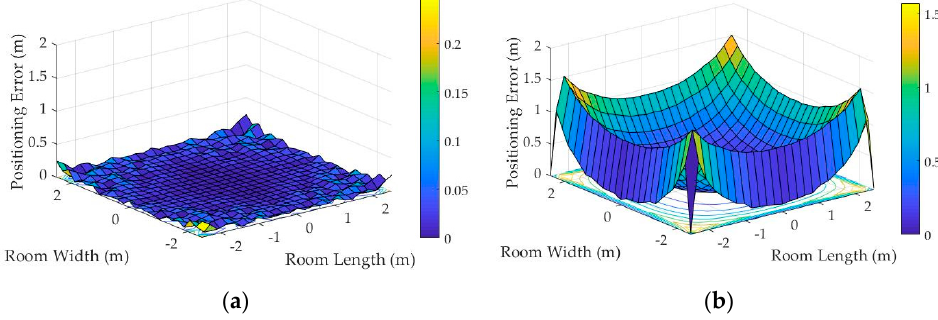
Figure 5. Positioning error using a Trilateration algorithm: ( a ) without multipath reflections and ( b ) with multipath reflections.